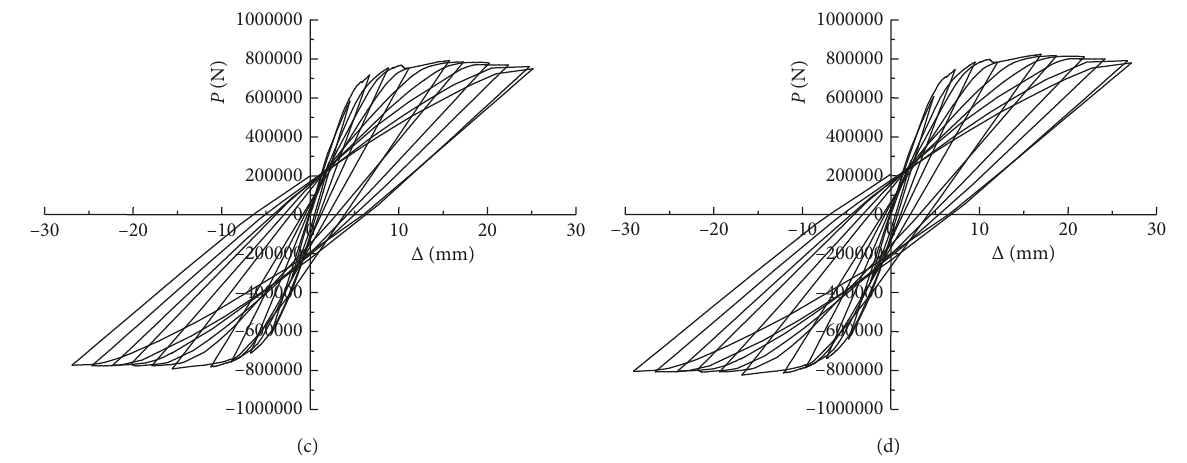
Figure 16: Hysteresis curves of frames with various axial compression ratios. (a) K-8. (b) K-1. (c) K-9. (d) K-10.